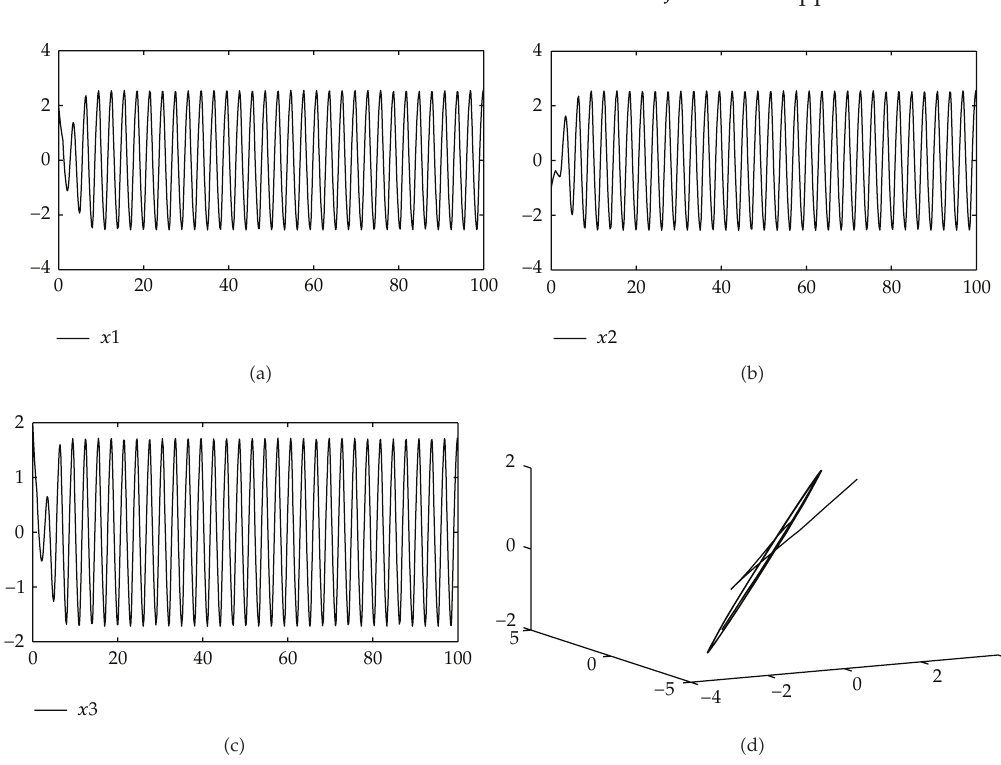
Figure 2: For system (cid:5) 3.4 (cid:6) , when τ (cid:7) 0 . 5 > τ ∗ , the periodic solution bifurcates from the